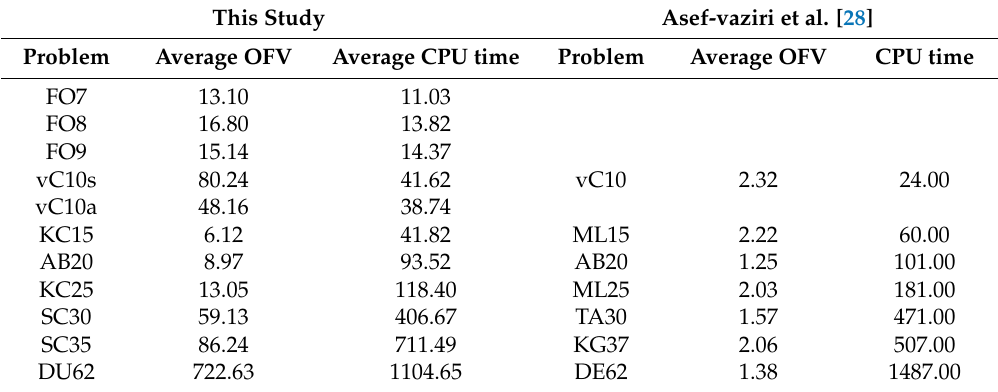
Table 5. The computation time